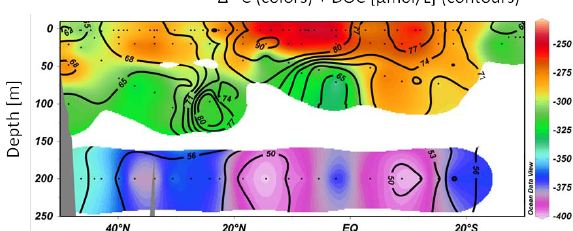
Fig. 5. Calculated SPE-DOM 1 14 C values (colors) and measured bulk DOC concentrations (contours) in the upper 250m of the water column in the eastern Atlantic Ocean. The 1 14 C Cal values and the DOC concentrations are significantly positively